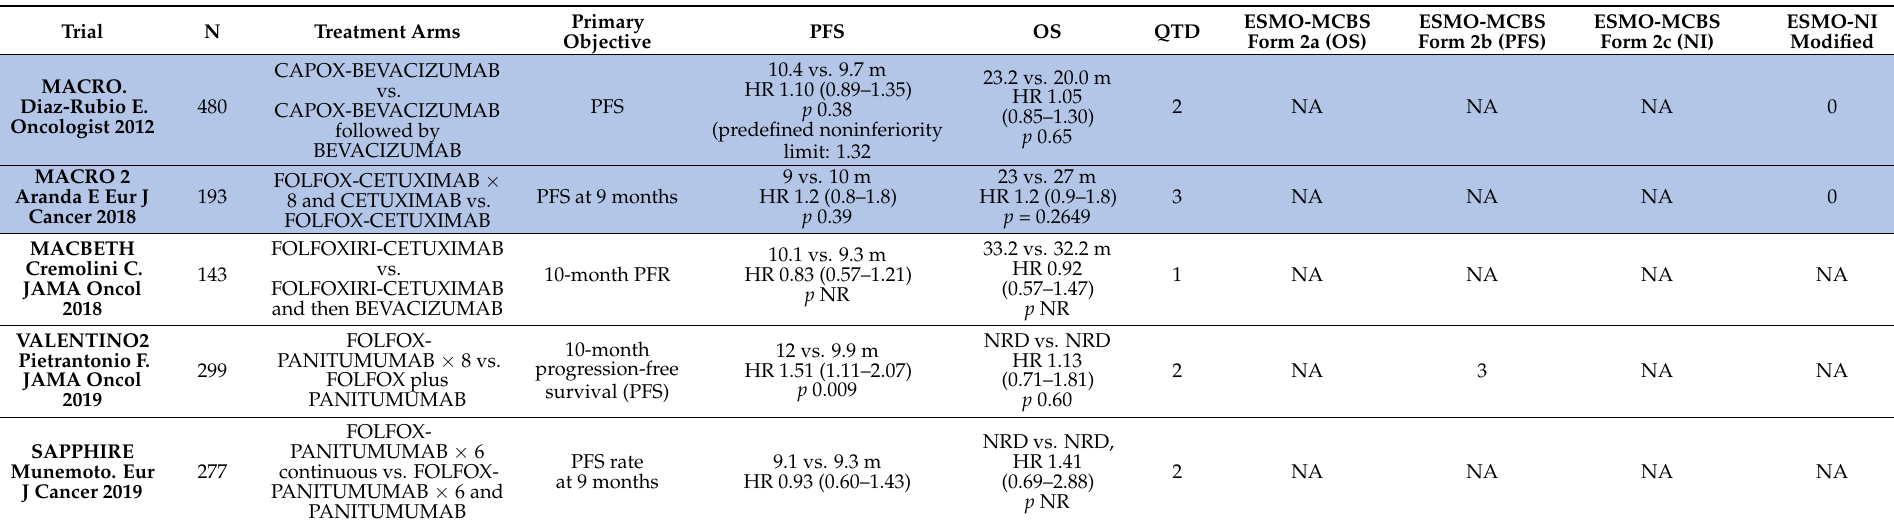
Table 9. Continuous treatment with chemotherapy doublets plus MAbs vs. continuous treatment with monotherapy plus